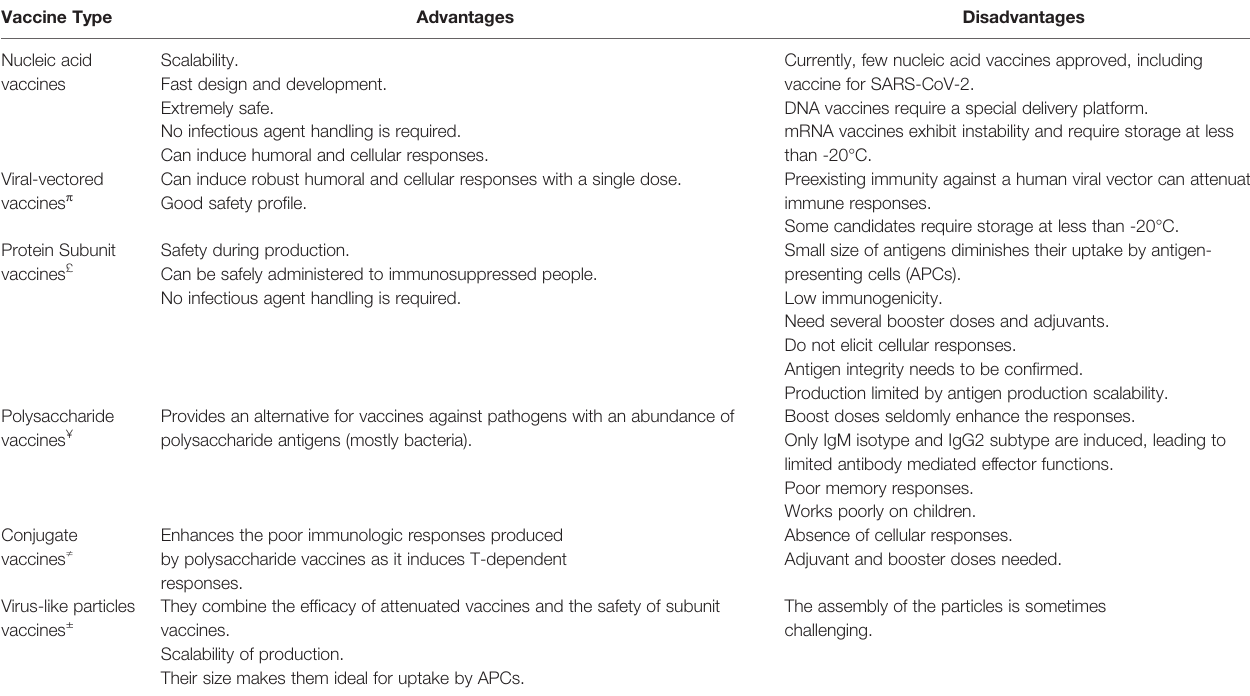
TABLE 4 | Advantages and disadvantages of the major vaccine platforms (Kyriakidis et al.,